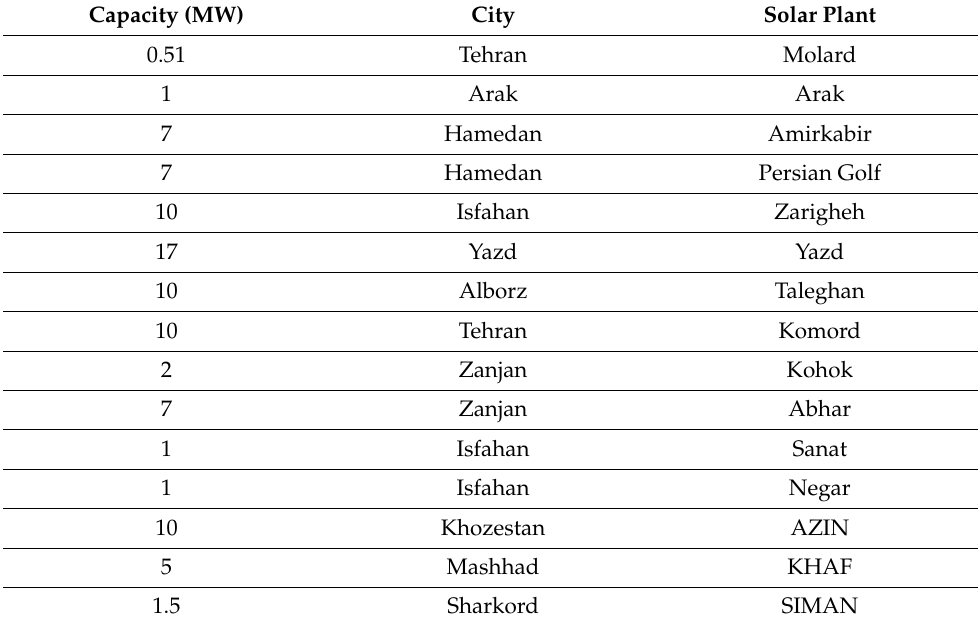
Table 4. Installed solar power plants in Iran.